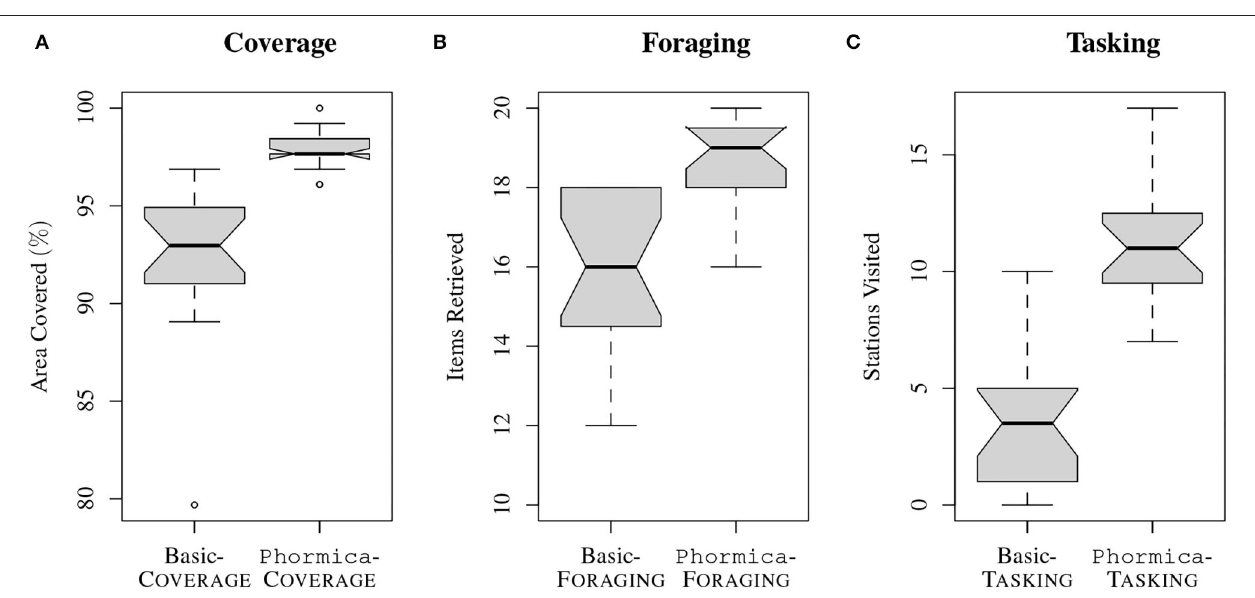
FIGURE 10 | Performance obtained in the missions (A) COVERAGE , (B) FORAGING , and (C) TASKING .